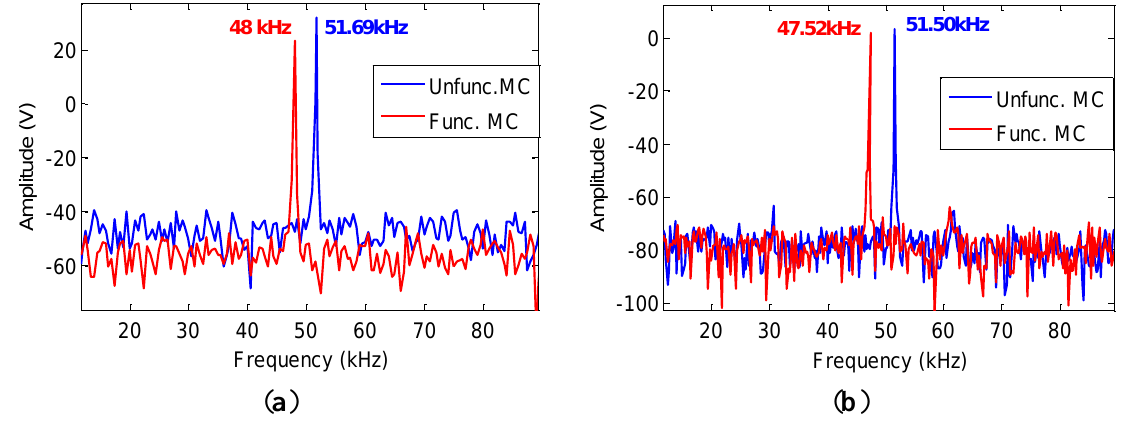
Figure 11. Shift in the first resonance frequency measured by ( a ) self-sensing bridge, ( b ) Laser vibrometer.